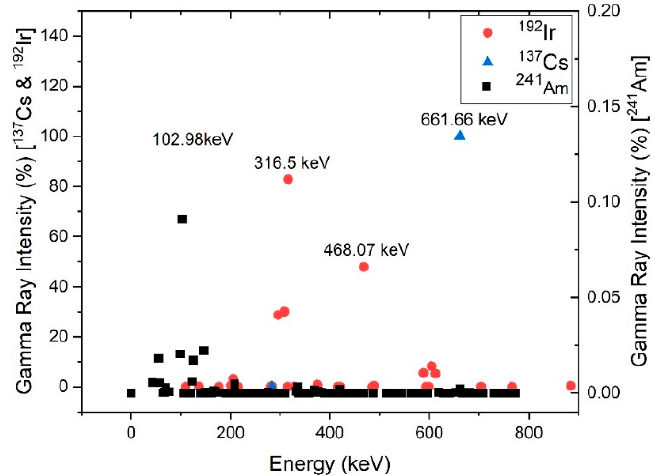
Figure 2. Gamma-ray characteristic energies and energy peaks of 192 Ir, 137 Cs and 241 Am.